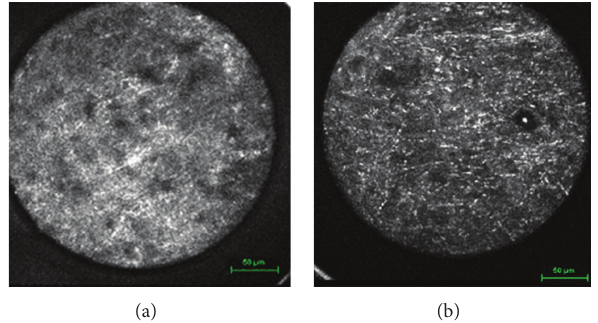
Figure 3: (a) Glioblastoma. (b) Astrocytoma.